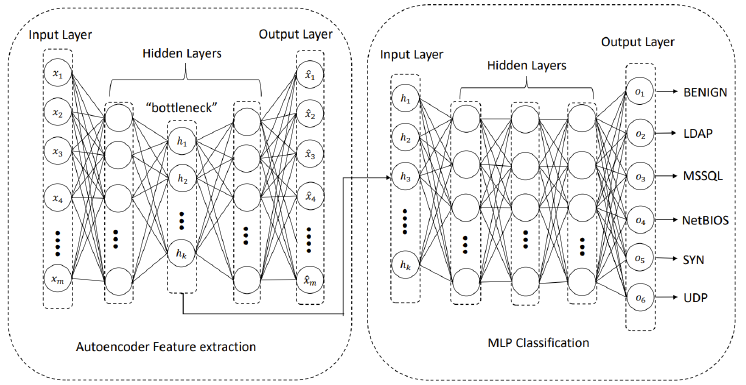
Figure 3. The overview of the hybrid